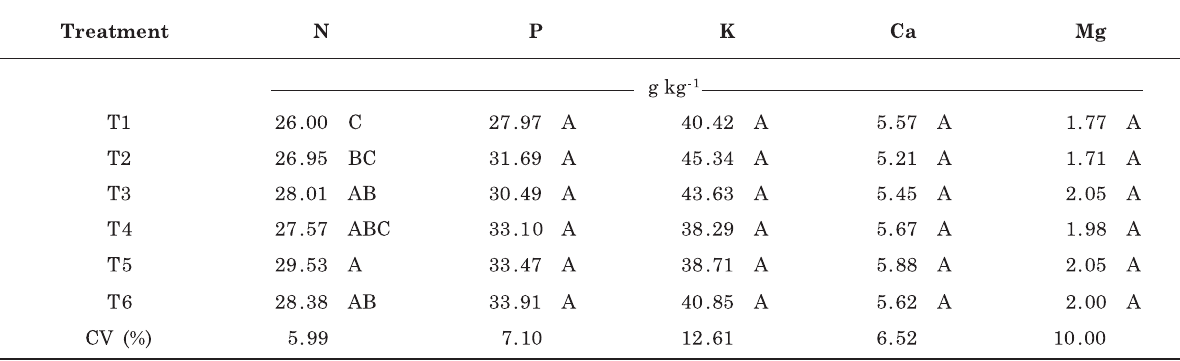
Table 1. Corn leaf nutrient concentration 85 days after sowing